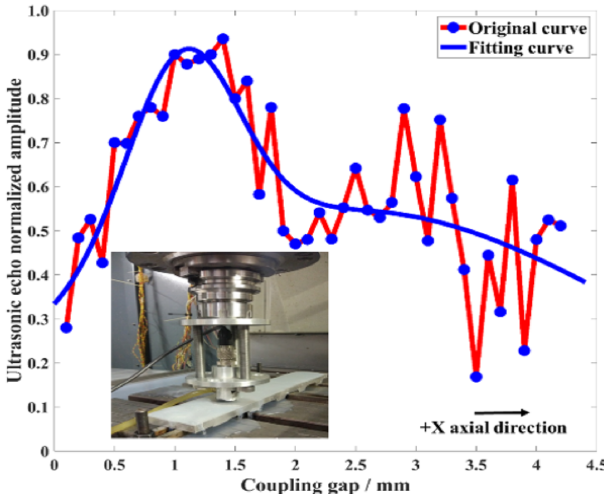
Figure 6. Amplitude of the ultrasonic echo signal for different cou- pling